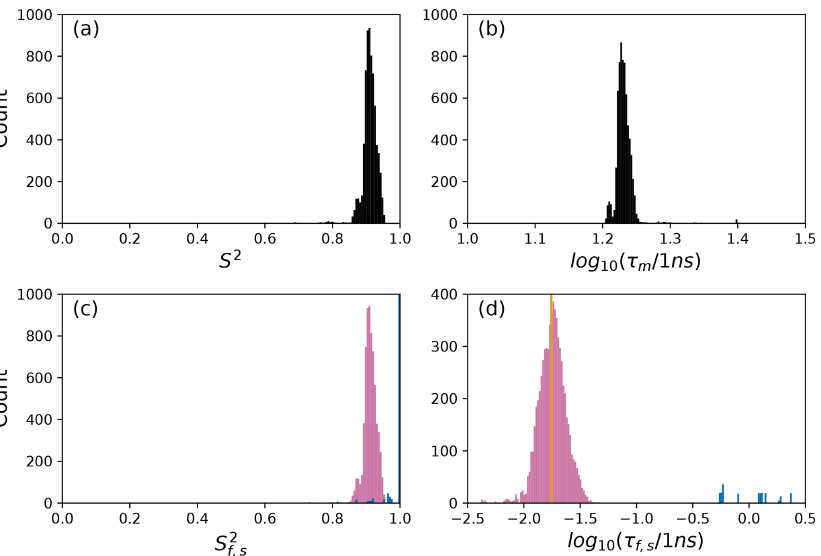
or τ f (reddish-purple) and f